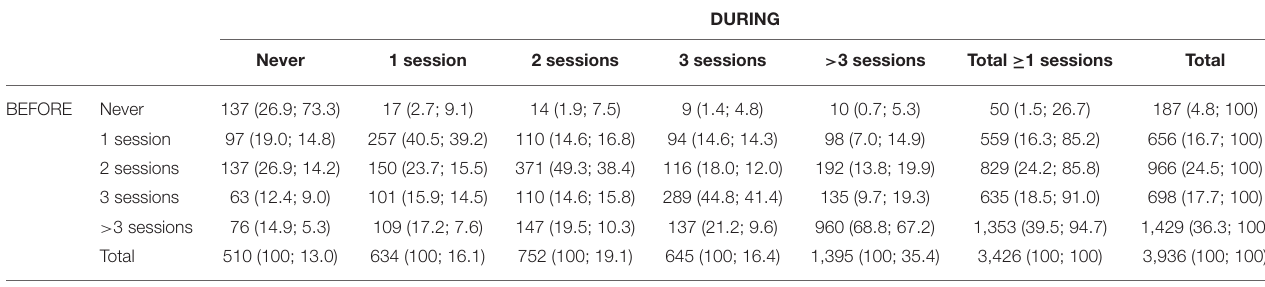
TABLE 10 | Contingency table for comparison of frequency (category percentages for during; category percentages for before) of duration of an individual session of non-organized light physical activity before and during lockdown. ≤ 30 min > 60 min Total